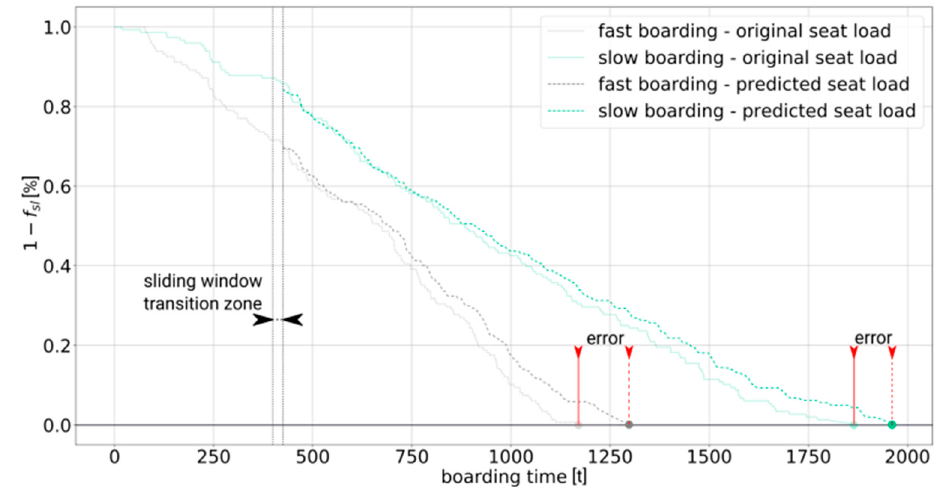
Figure 5. Prediction of seat load progress with LSTM model for two exemplary boarding events (prediction is based on the progress reached after 400 s).